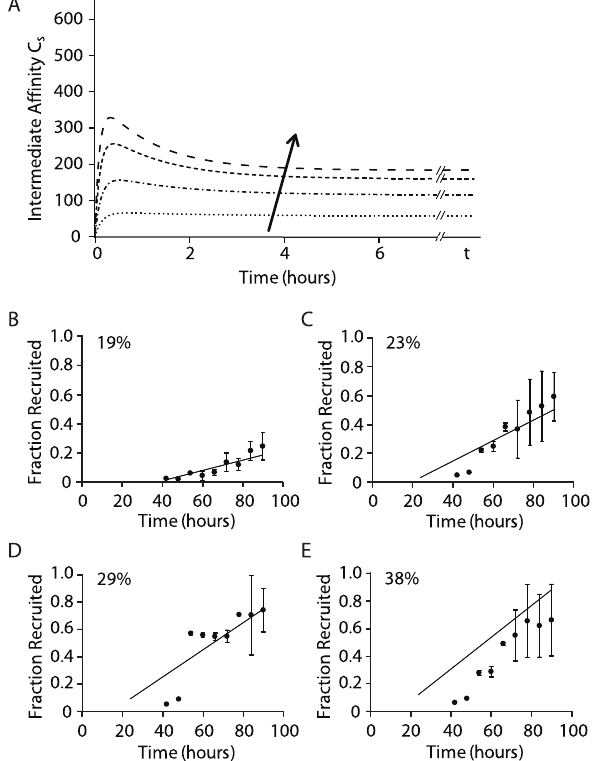
Figure 3. Steady state cell surface complexes determine NK cell recruitment to the cell cycle. A . Surface IL-15/IL-15R complex numbers were calculated from model simulations for IL-15 concentra- tions of 9, 25, 50, and 75 ng/ml and were plotted for t hours. The arrow represents increasing IL-15 concentration. B–E . The cell cycle threshold (generated C s from the immediate affinity model) is used to predict the fraction of NK cells recruited to divide at various times. The model predictions (solid lines) are compared with results generated from independent experiments (filled circles) where IL-15 concentrations were 9 ng/ml ( B , n=3), 25 ng/ml ( C , n=4), 50 ng/ml ( D , n=2), and 75 ng/ml ( E , n=3). The quality of prediction is represented by the normalized root mean squared deviation (NRMSD). The NRMSD of model prediction vs. experimental data are shown as percentages in the upper left of each graph. For reference, linear regression was performed for all four sets of experimental data, and the NRMSD values of the linear regressions were 12% (9 ng/ml), 5% (25 ng/ml), 19% (50 ng/ml), and 9% (75 ng/ml).